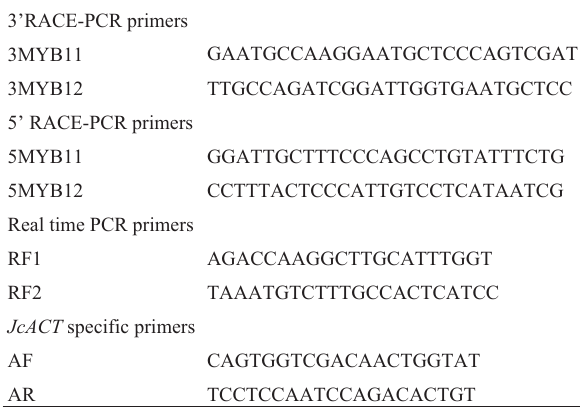
Table 1 - Primer sequences (Nucleotide sequences from 5’to